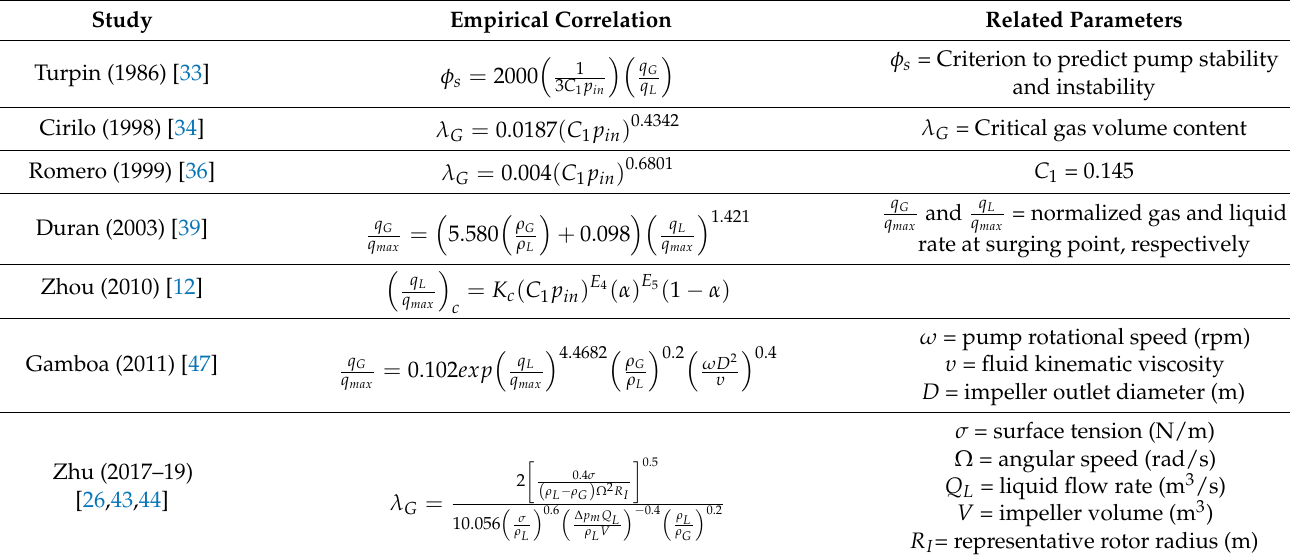
Table 5. Empirical correlations used to predict pump instability or surging in two-phase flow conditions. Study Empirical Correlation Related Parameters